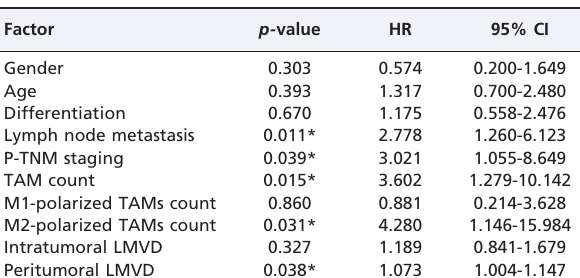
Table 2 - Hazard ratios (HR), 95% confidence interval (CI) and p- value for the 65 patients with lung